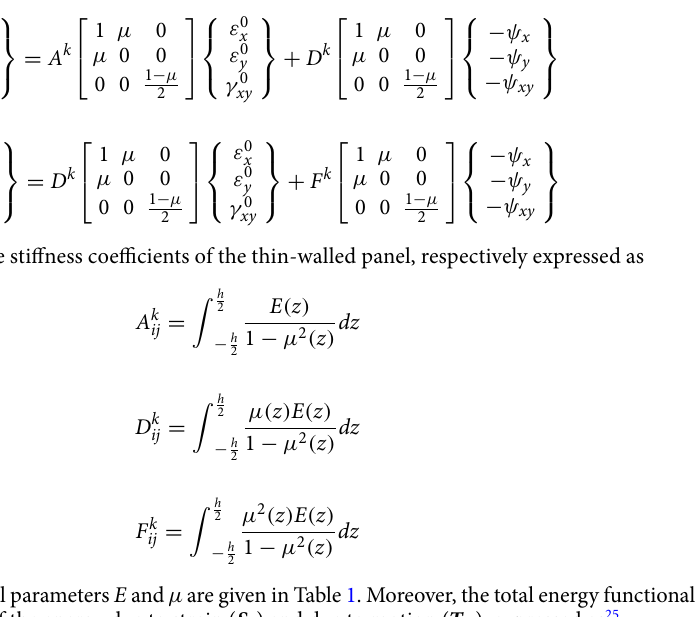
v u = ∂ /∂ y represent the normal strains while γ 0 /∂ x and ε 0 where ε 0 x = ∂ y in the reference surface. Also, the terms ψ x , ψ y and ψ xy are the middle surface curvature changes. The transverse shearing strain components γ xz and γ yz are assumed to be zero due to the thin-walled nature of the aluminium panel. The resultant stress σ( x , y ) comprises of both the force ( Q ) and moment ( M ) resultants which can be expressed in components form as